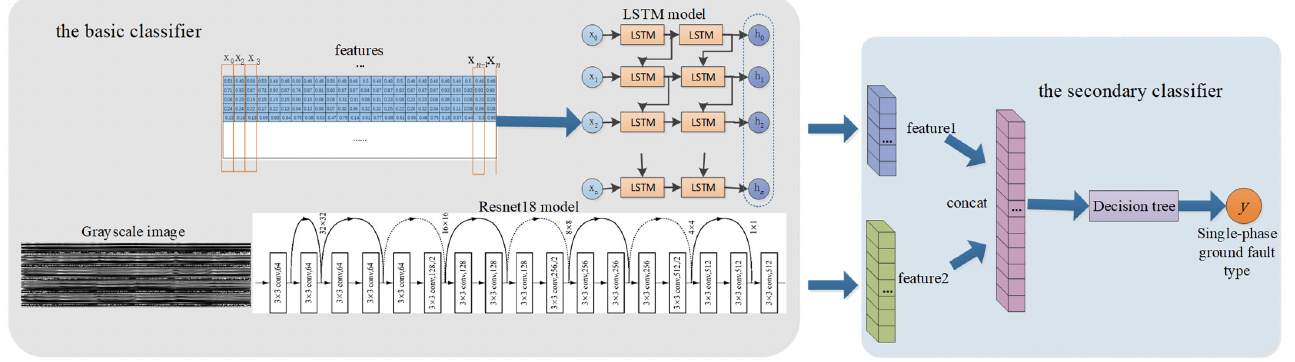
Figure 10. The Resnet18_LSTM_DT model framework.